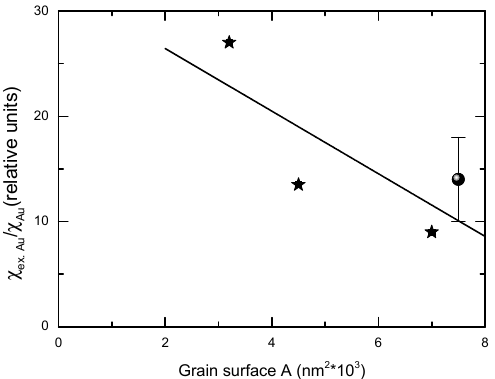
Figure 10. The gold diamagnetism in CoFe 2 O 4 @SiO 2 @AuN nanostructures as function of the mean surface of Au nanograins, in relative units (referred to bulk gold diamagnetism) ( * ). The data from [31] are also given ( ● ).